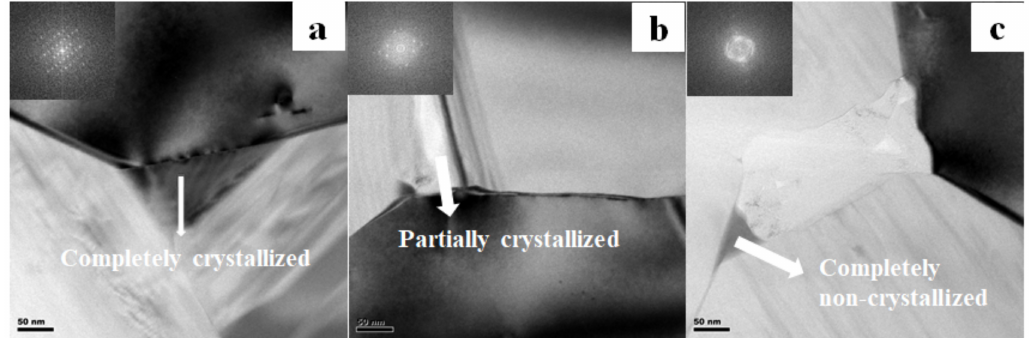
Figure 13. Di ff erent triple junction grain boundaries of the SiC ceramic sample with EY9 sintered at 2000 ◦ C: ( a ) completely crystallized, ( b ) partially crystallized, and ( c ) completely non-